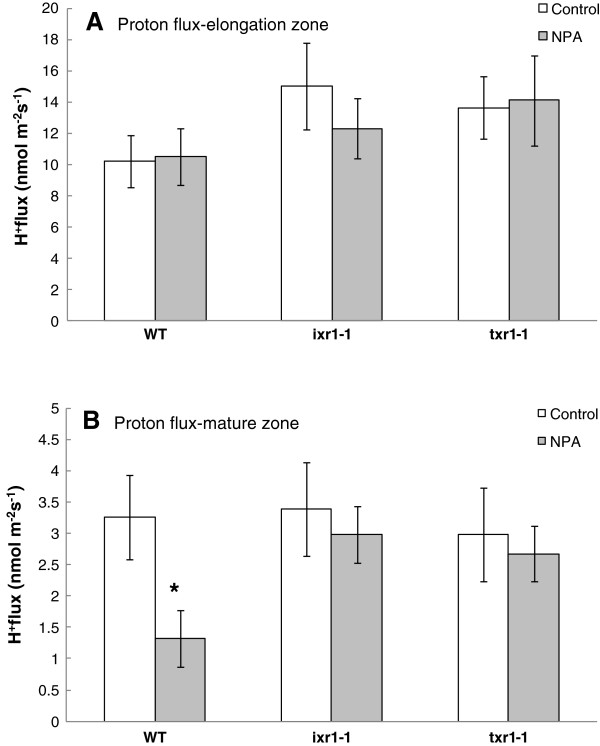
Net H+ fluxes from various root zones of Arabidopsis lines treated with auxin transport inhibitor NPA. Measurements were taken from the elongation (A) and mature (B) root zone of Arabidopsis thaliana plants after 24 h of treatment with NPA. Mean ± SE (n = 8). The flux convention is “influx positive”. * significantly different from the control of that genotype (*P < 0.05, t test).